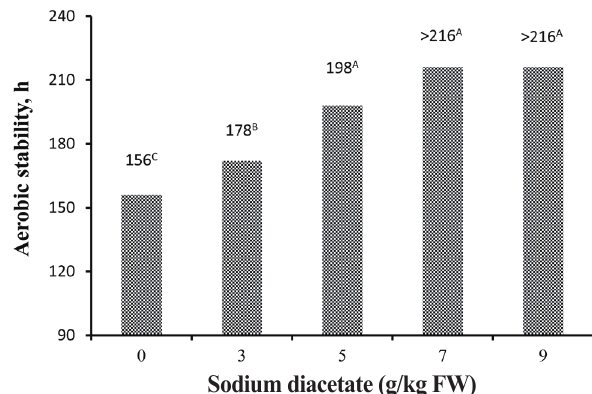
Figure 2. Flieg’s point of alfalfa silages treated with 0, 3, 5, 7, and 9 g/kg FW sodium diacetate ensiled for 60 days. Vertical bars are the standard errors of the means, bars with unlike letters differ (p<0.05, n = 5). FW, fresh weight.